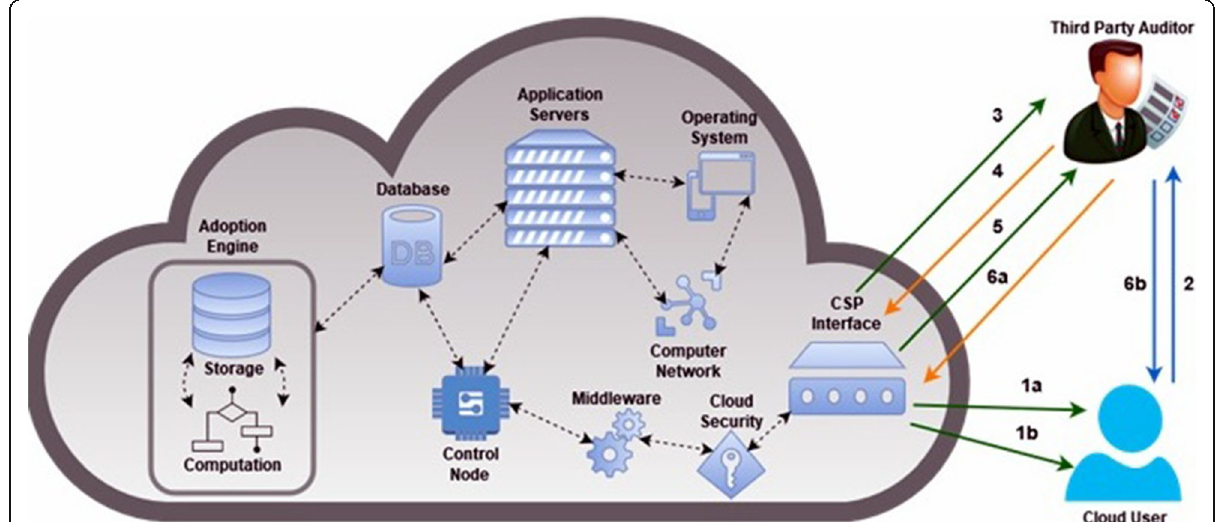
Fig. 1 Privacy-preserving service oriented architecture for cloud